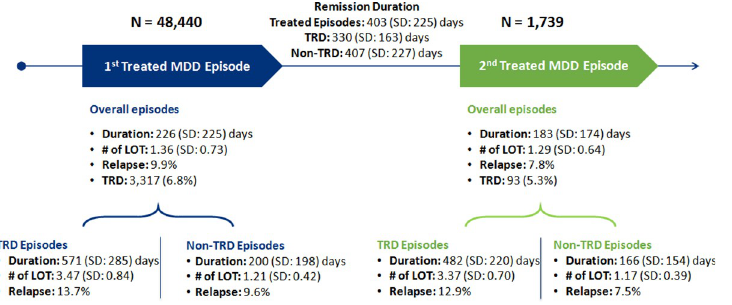
Fig 3. Characteristics of 1 st and 2 nd treated MDD episodes. LOT: line of therapy; MDD: major depressive disorder; TRD: treatment-resistant depression.